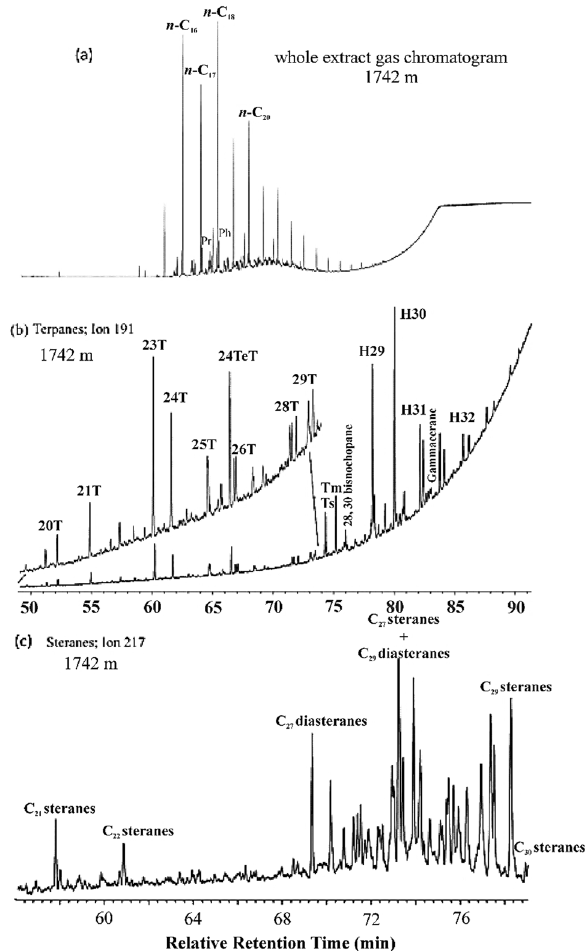
Figure 8. ( a ) Whole extract gas chromatogram of the Bijnot-1 sediment (1742 m) showing n -alkane and isoprenoid distributions, ( b ) selected ion chromatogram (191) showing the distribution of tricyclic and pentacyclic (Hopanes) terpanes in a representative sample from Bijnot-1. Letters with T and H refer to tricylic terpanes and hopanes, respectively, the numbers on the peaks represent the carbon numbers of the respective compound, and 24TeT indicates 24 tetracyclic terpane, and ( c ) selected ion chromatogram (217) showing the distribution of steranes and diasteranes. The numbers on the peaks represent the carbon numbers of steranes and diasteranes.